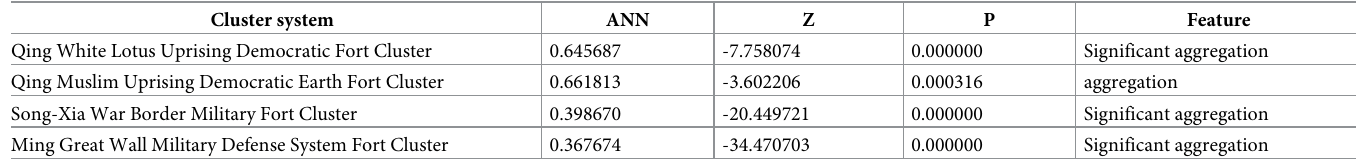
Table 2. Analysis of the average nearest neighbor of the different cluster systems.